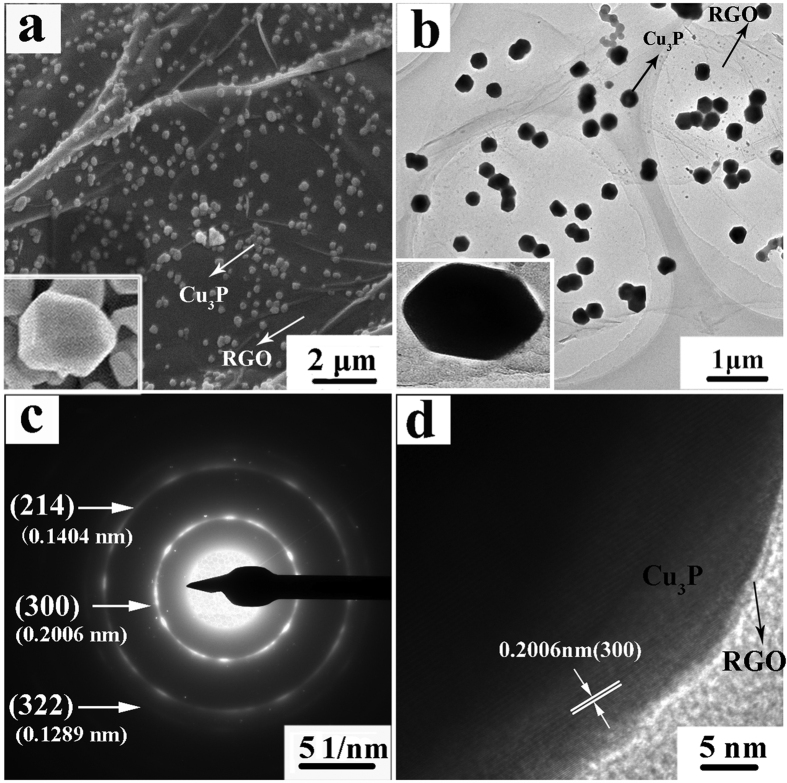
(a) FESEM image, (b) TEM image, (c) SAED pattern, and (d) HRTEM image of Cu3P/RGO nanocomposite.